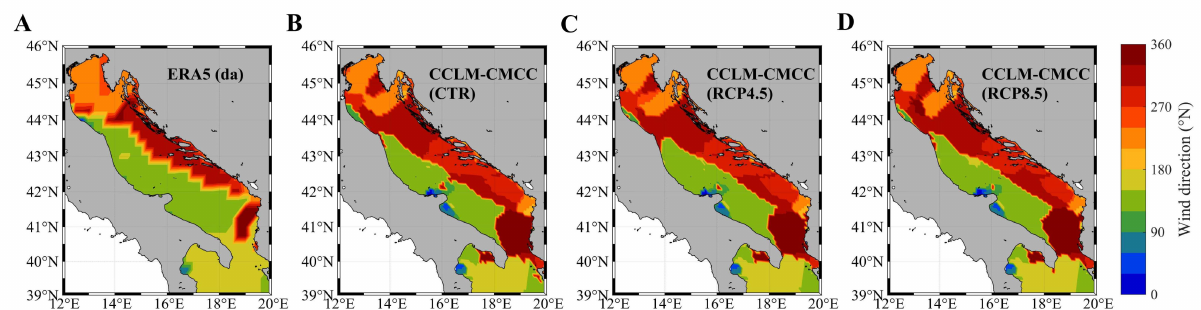
Figure 7. Mode (most probable value) of the wind direction of flow from ERA5 ( A ); daily average, da) and CCLM-CMCC (present-day CTR, and future projections RCP4.5 and RCP8.5; ( B – D